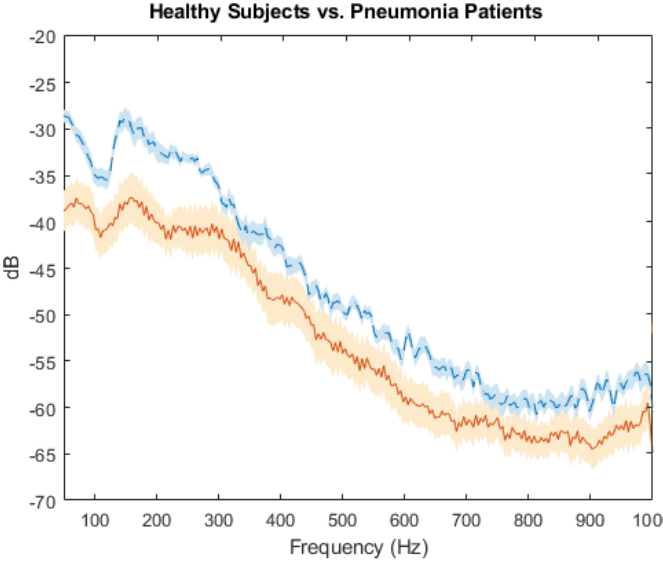
Figure 5. The frequency spectrum from 0–1000 Hz from the sound signal recorded from the left lower lobe of eight healthy subjects and five pneumonia patients, mean values are plotted for the pneumonia patients (solid line) and healthy subjects (dotted line) with standard error